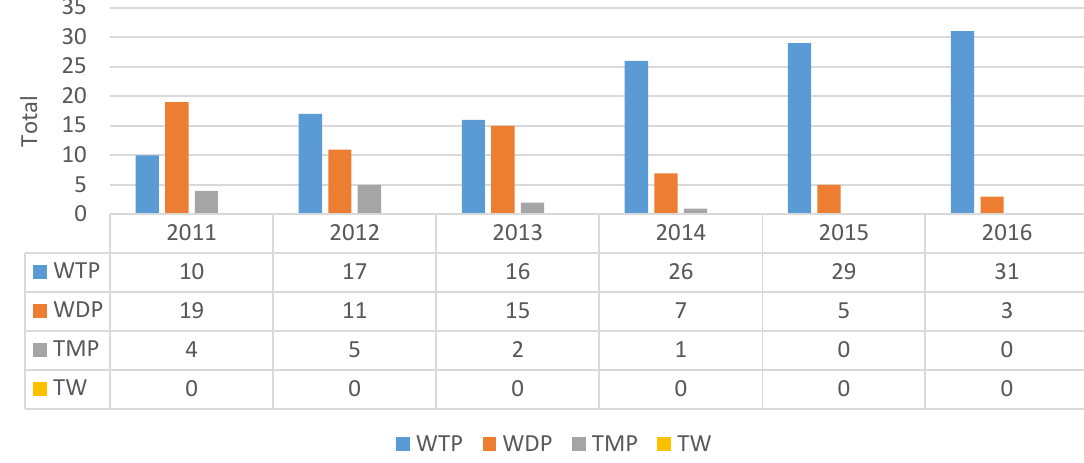
Figure 1. BPK opinion for LKPD provinces in Indonesia from 2011 to